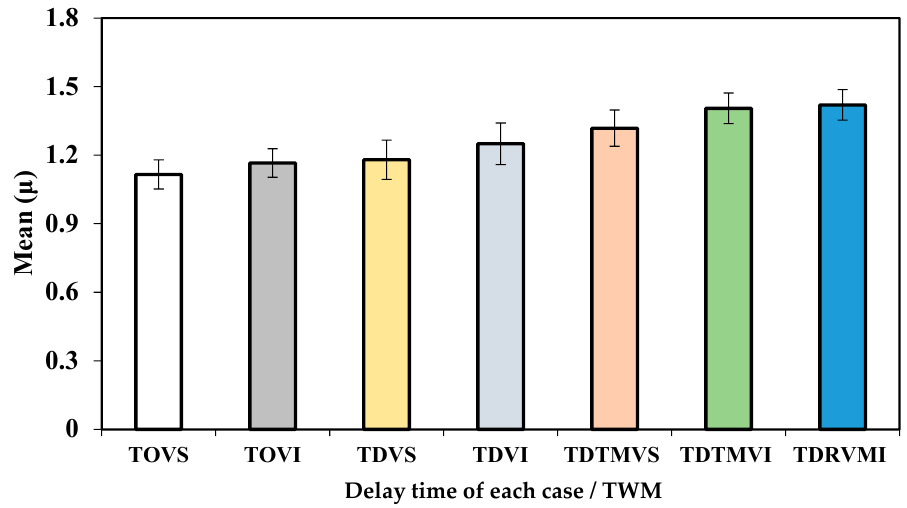
Figure 12. Comparison of relative delay time of SDS and HDS with standard error bars.